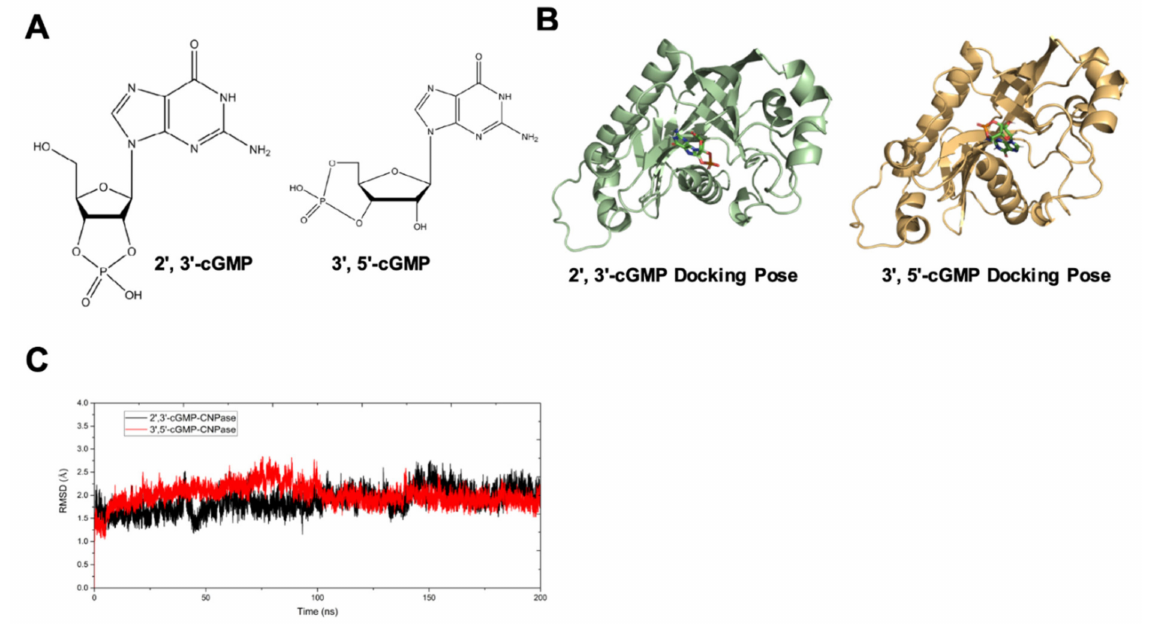
Figure 5. In silico simulation of the dynamic interaction of CNPase with 2 (cid:48) ,3 (cid:48) -cGMP and 3 (cid:48) ,5 (cid:48) -cGMP. ( A ) The chemical structures of 2 (cid:48) ,3 (cid:48) -cGMP and 3 (cid:48) ,5 (cid:48) -cGMP. ( B ) The docking complex of CNPase with 2 (cid:48) ,3 (cid:48) -cGMP or 3 (cid:48) ,5 (cid:48) -cGMP. ( C ) The time course of the root-mean-square deviation (RMSD) of the 2 (cid:48) ,3 (cid:48) -cGMP-CNPase (black) and 3 (cid:48) ,5 (cid:48) -cGMP-CNPase (red) complex system in a simulation of 200 ns.